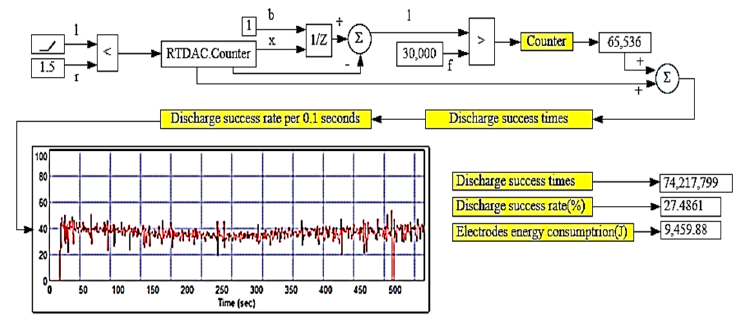
Figure 7. VisSim monitoring of the wave pattern.